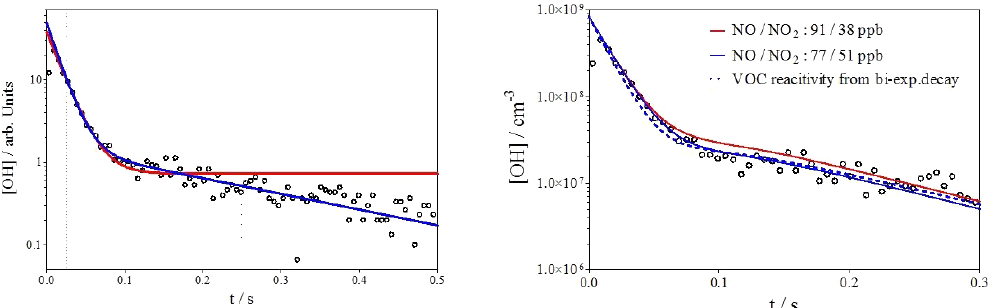
Figure 4. Typical OH decay monitored by the UL-FAGE instrument under high NO x conditions. Left panel: mono (red, fitting window: 0.025–0.2s) and bi-exponential (blue, fitting window: 0.025–0.9s) fits of the experimental data shown as plain lines. Right panel: compar- ison of the experimental trace with model simulations (see text and Table S3), VOC concentrations have been adjusted to reproduced the experimental decay. Plain red line: measured NO and NO 2 mixing ratios. Plain blue line: NO and NO 2 mixing ratios calculated after addition of O 3 within the photolysis cell. Dotted blue line: VOC reactivity at the value deduced from the bi-exponential decay.